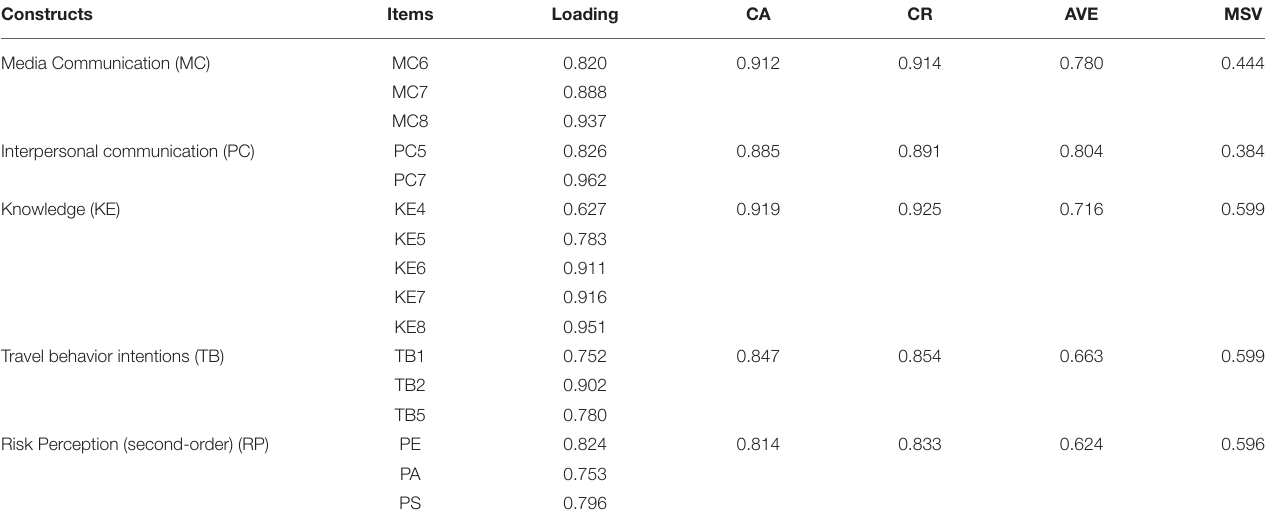
TABLE 2 | Confirmatory factor analysis. Constructs Items Loading CA